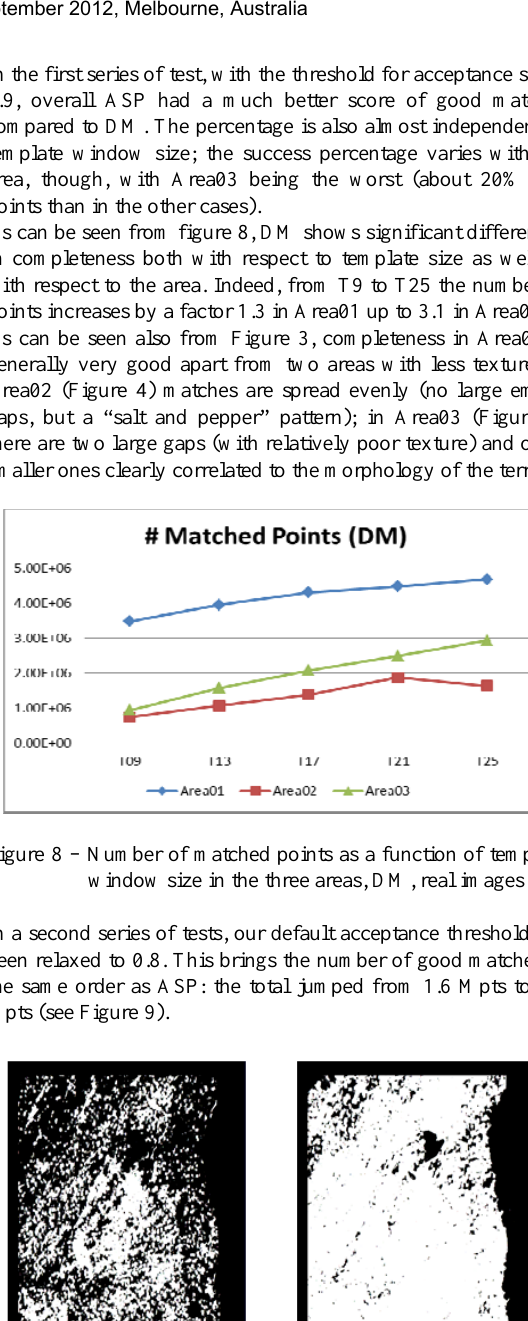
Figure 7 - RMSE (m) of the DTM produced by DM from synthetic images, as a function of the template size.